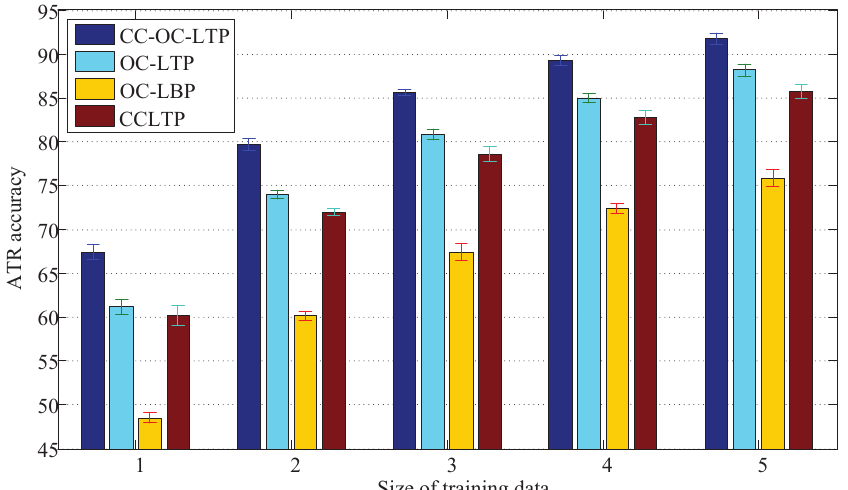
Figure 8. Recognition accuracy comparison for CC_OC_LTP, OC_LTP, OC_LBP and